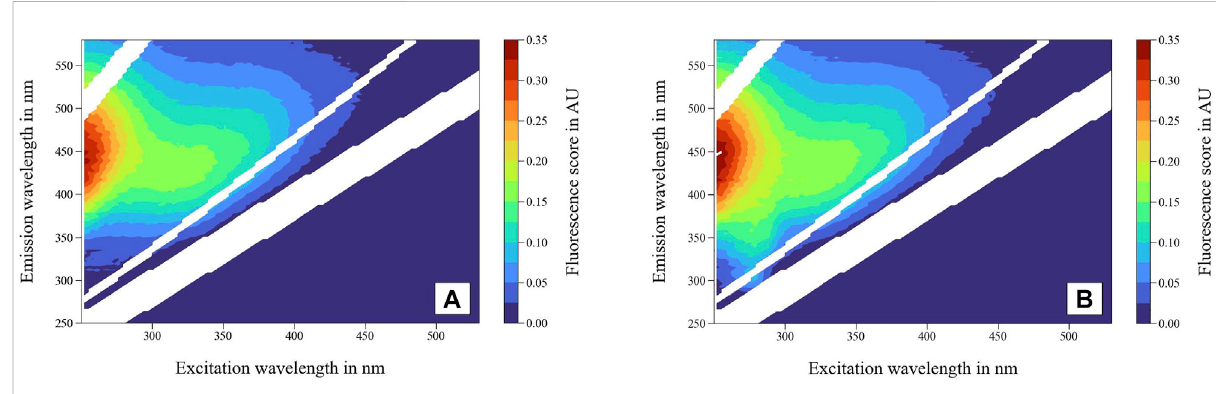
FIGURE 4 Excitation emission matrix(EEM) (A) oftap water(S1)and (B) tap water +vol% 0.007LBmedium (S3).Rayleigh andRamanscatteringisremoved and interpolated,